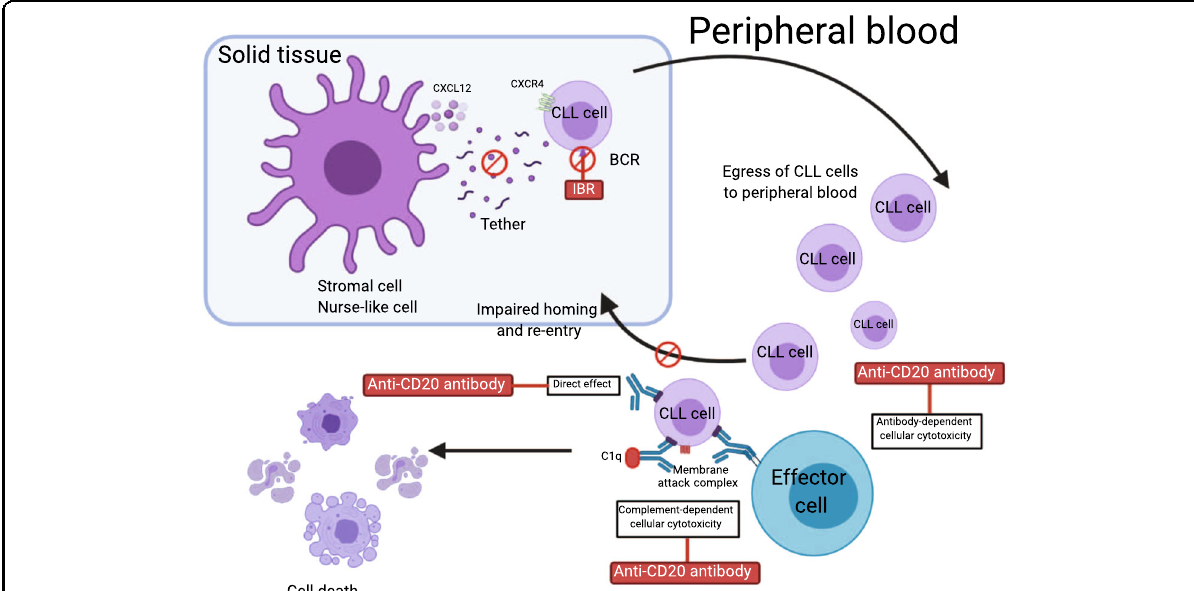
Fig. 1 Rationale for ibrutinib combination with monoclonal antibodies. Ibrutinib (IBR) reduces levels of smCXCR4, leading to enhanced CLL cell egress from the lymph nodes and spleen to the circulation and impaired homing to the nodal compartments. In peripheral blood, CLL cells are exposed to monoclonal antibodies by three major independent mechanisms: (1) antibody-dependent cellular cytotoxicity (ADCC), (2) complement- mediated cytotoxicity, and (3) direct apoptosis. This fi gure was created with BioRender.com. BCR, B cell